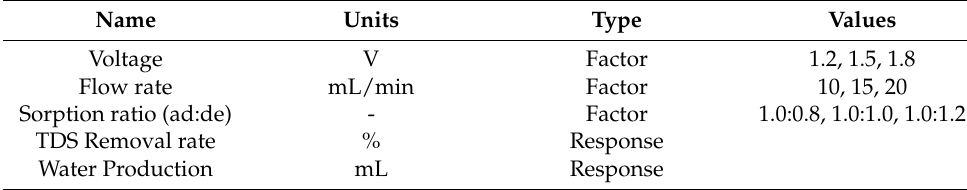
Table 3. Factors and responses used in